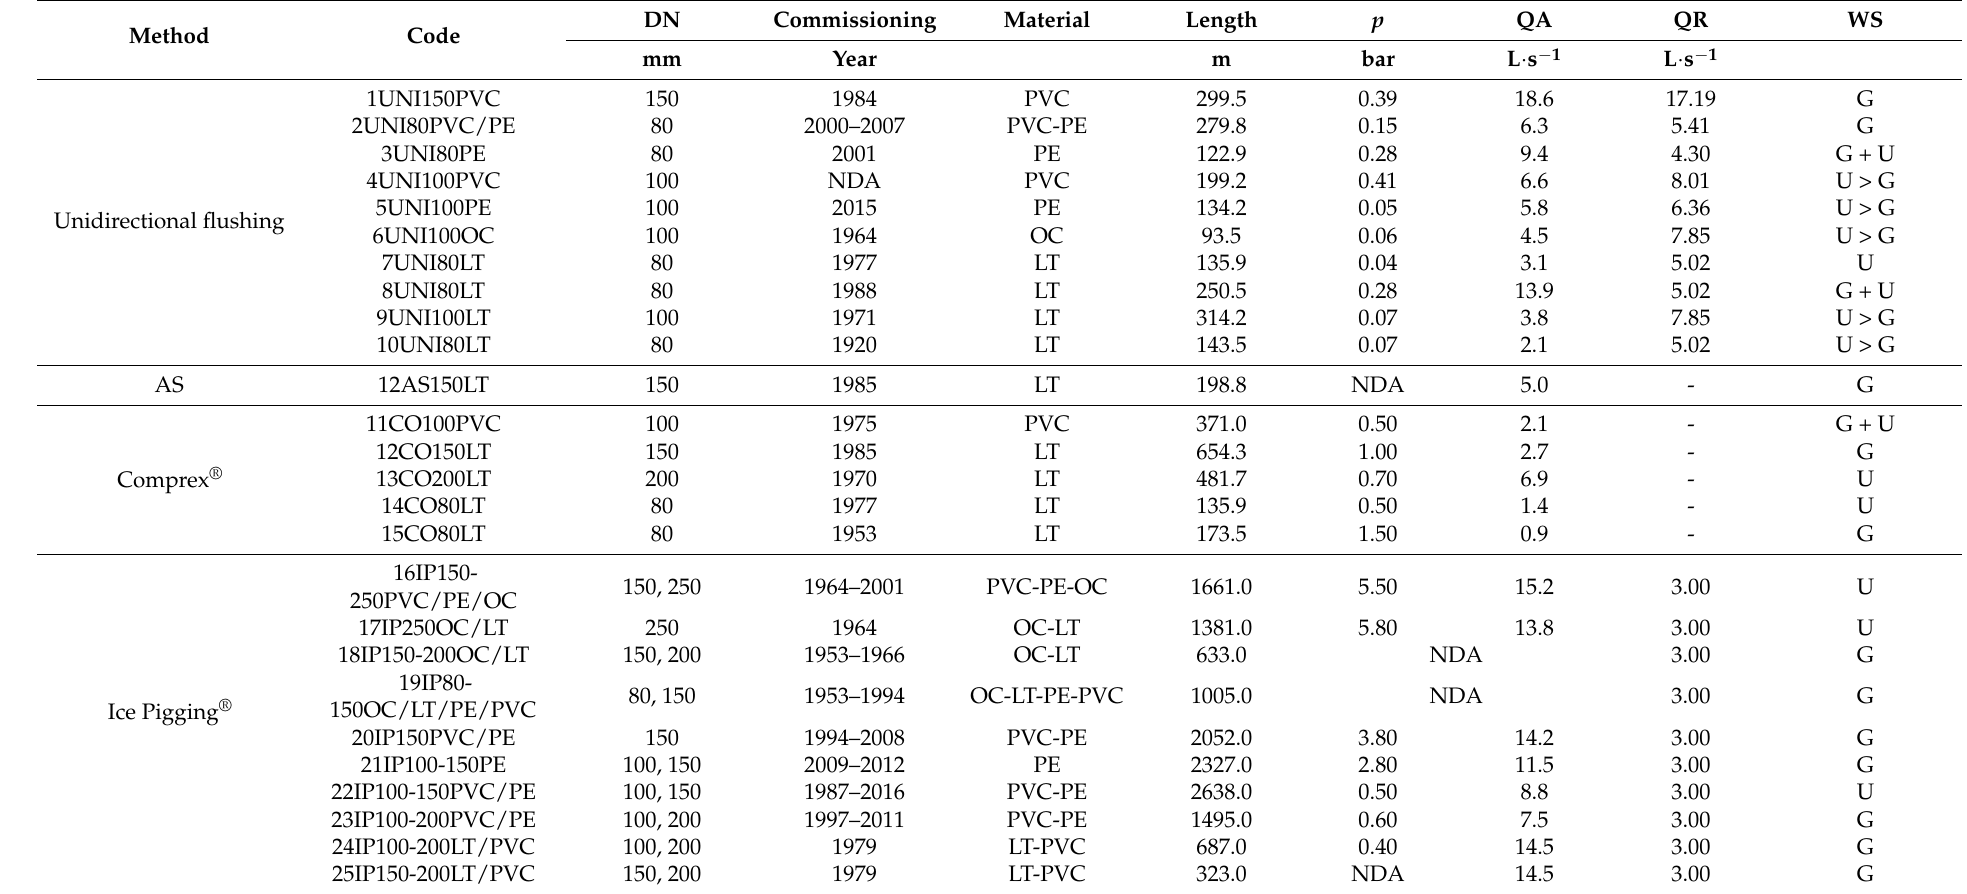
Table 2. Properties of the cleaned pipes and cleaning parameters (NDA—no data available; DN—nominal diameter; p—hydrodynamic pressure; QA—flow achieved; QR—flow required; WS—water source; G—groundwater— U—underground water).